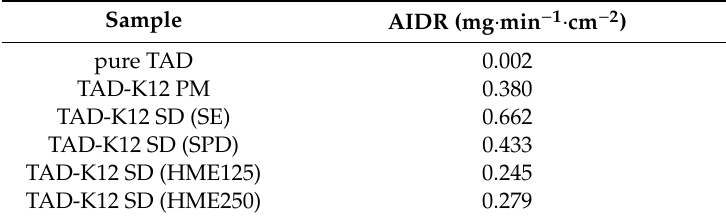
Table 1. Apparent intrinsic dissolution rate of TAD (K12 polymer matrix).